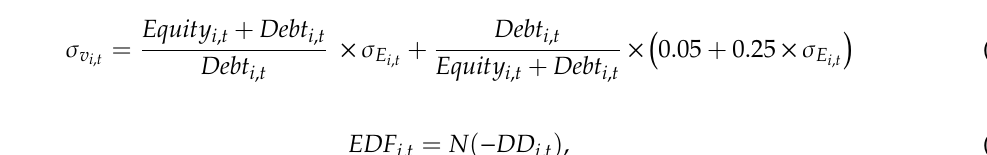
Table 1. Descriptive Statistics—the initial sample consists of all U.S. common stocks from 1987 to 2019, which are both in the Compustat and Center for Research in Security Prices (CRSP) databases. Following (Brogaard et al. 2017), we exclude financial firms (standard industrial classification (SIC) codes between 6000 and 6999). We also require all firms to have non-missing data for all variables in our main regressions. The final sample has 9888 unique firms and 84,132 firm-year observations. Variable definitions are as in Table A1.